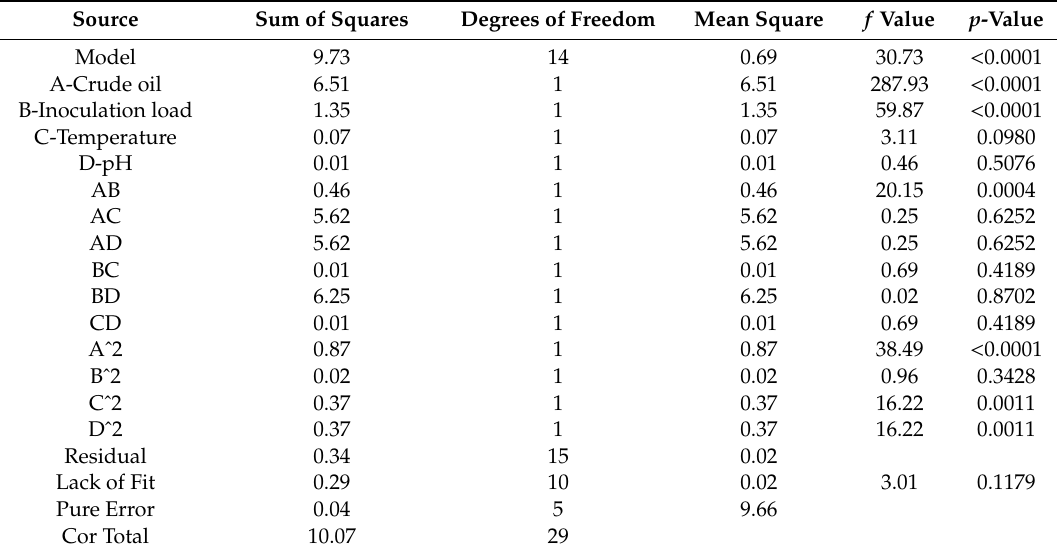
Table 1. Results of ANOVA for the response surface quadratic